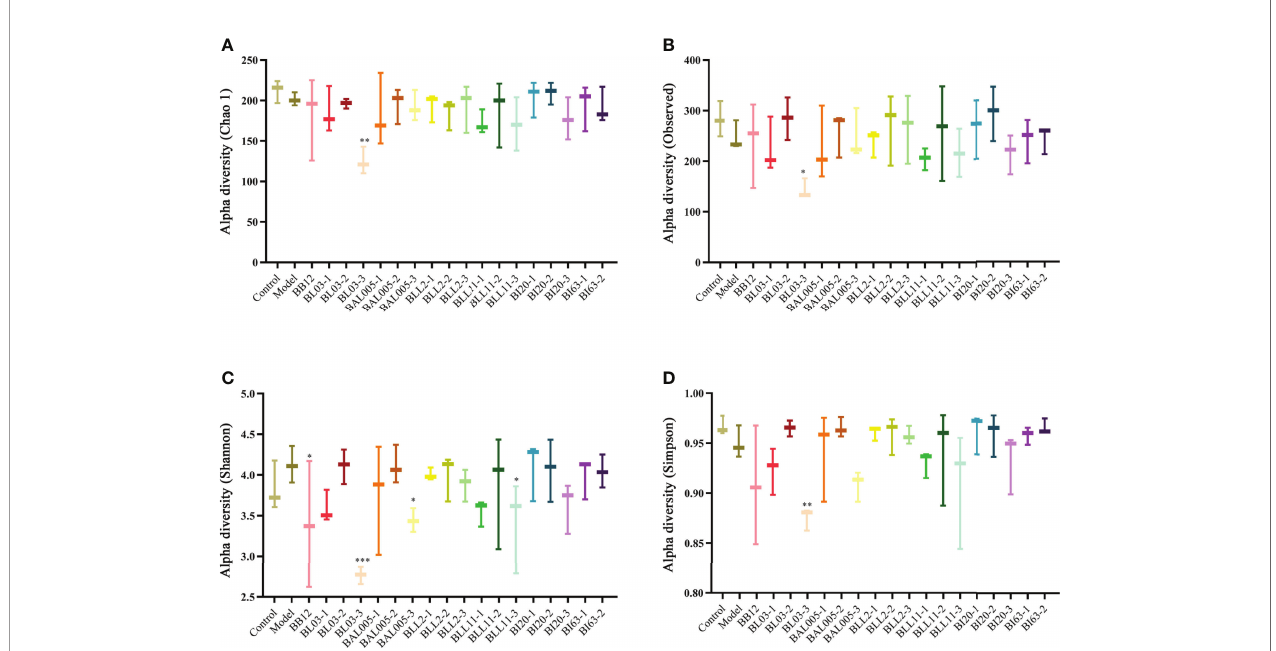
FIGURE 7 | The alpha diversity of intestinal microbiota in mice treated with different embedding methods. Chao 1 index (A) . Observed species index (B) . Shannon index (C) . Simpson index (D) , where * means P < 0.05, **P < 0.01, ***P <